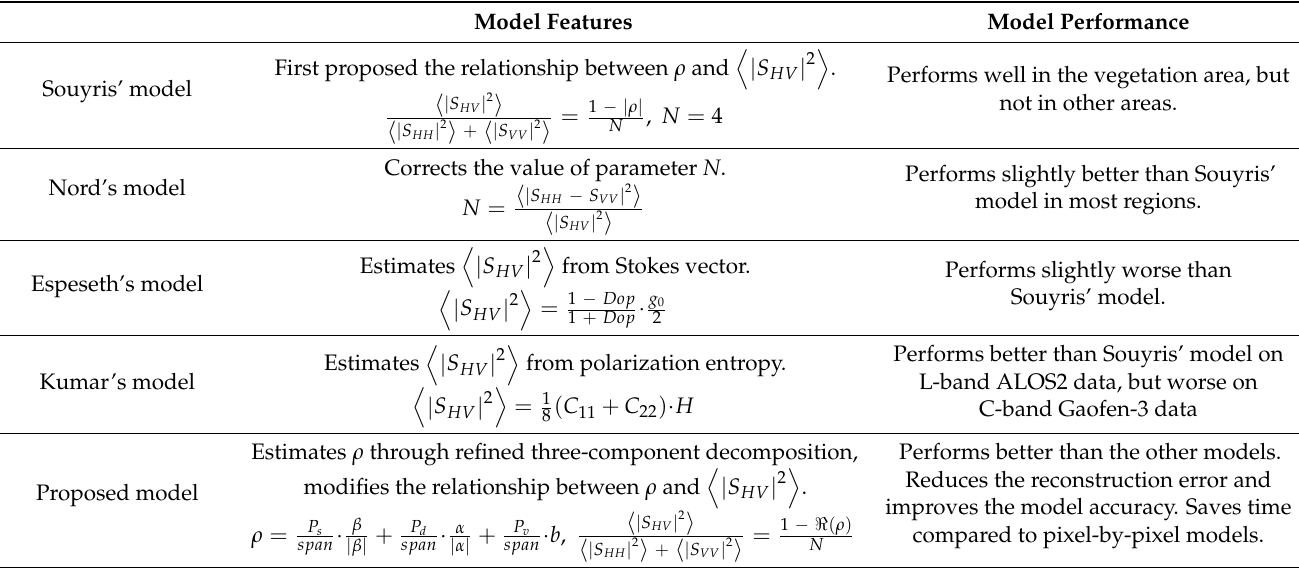
Table 5. The comparison between the proposed model and similar studies. Model Features Model